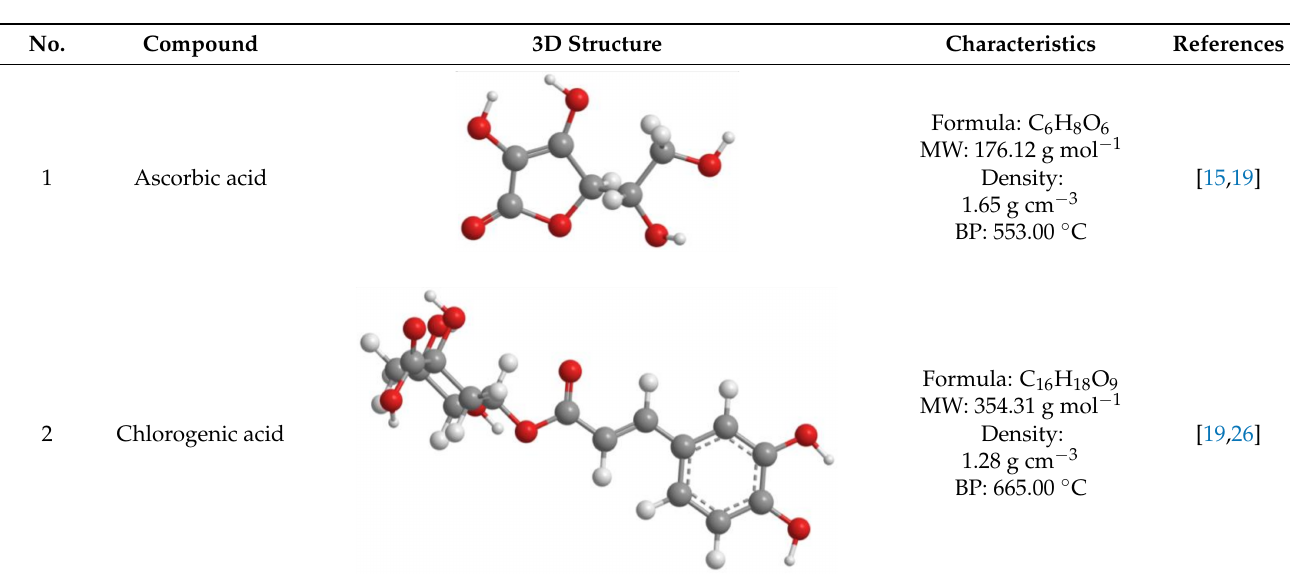
Table 3. Bioactive compounds identified in articles included in this